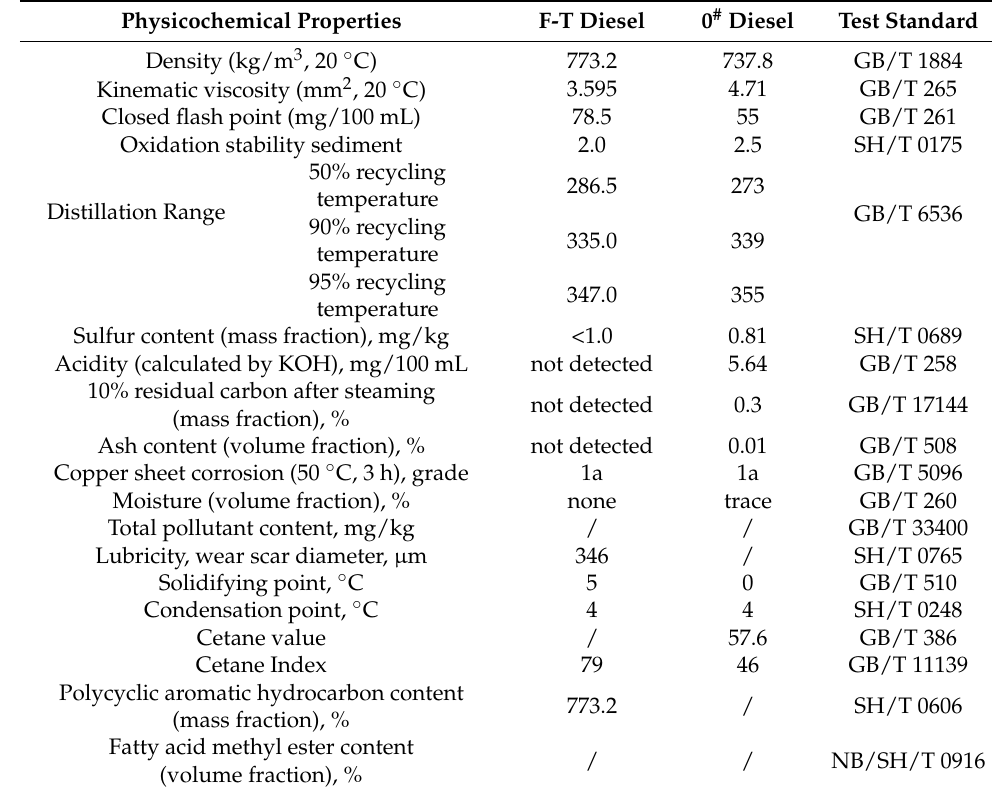
Table 1. Comparison table of physicochemical properties of Fischer-Tropsch synthetic diesel (F-T diesel) and 0 # diesel. (0 # means number